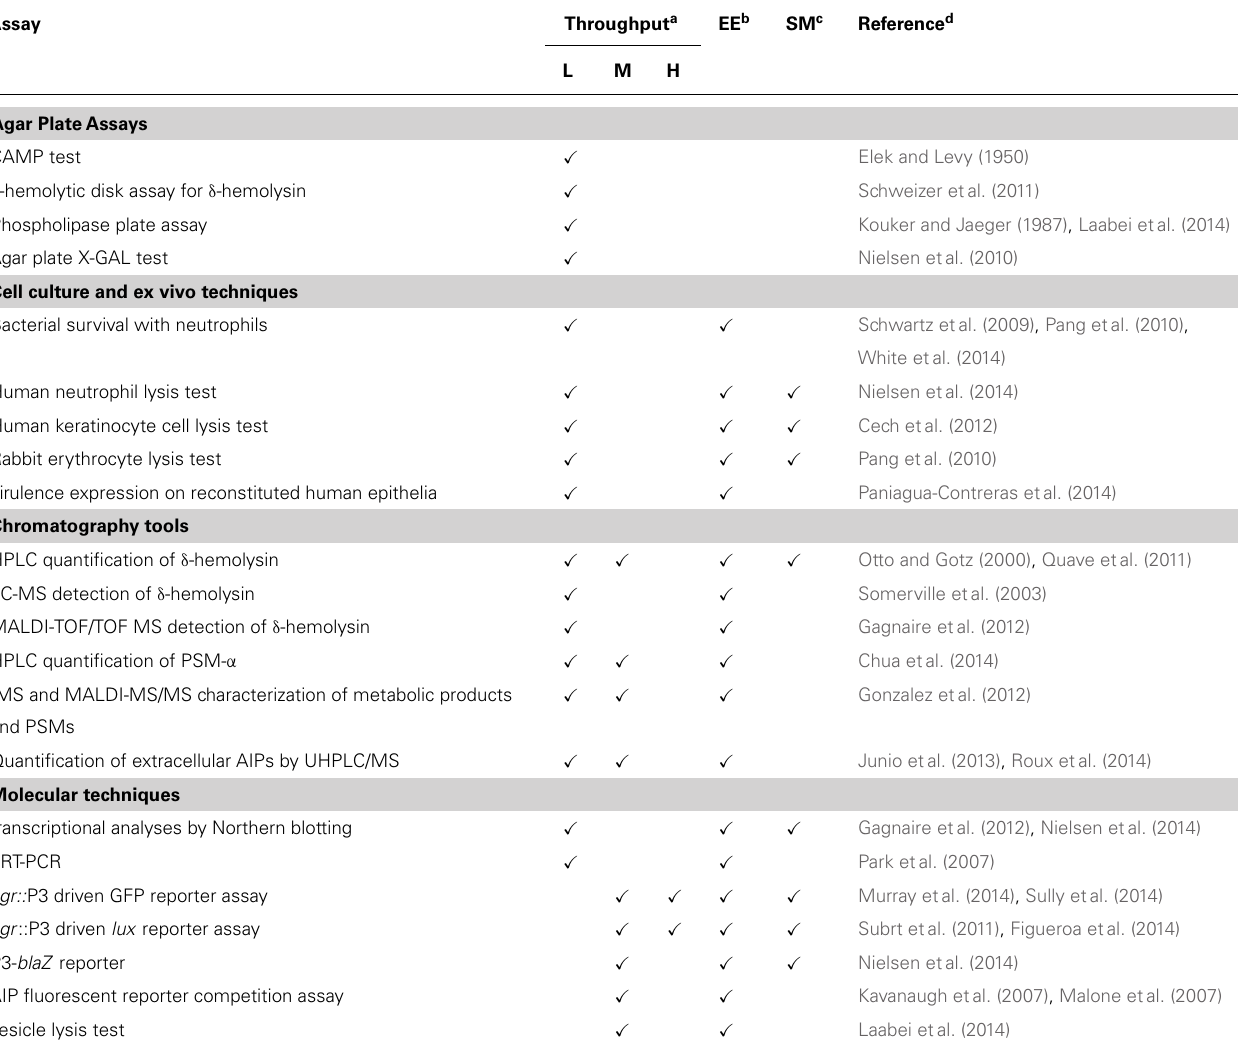
Table 2 | Summary of existing tools for assessing agr function. Assay Throughput a EE b SM c Reference